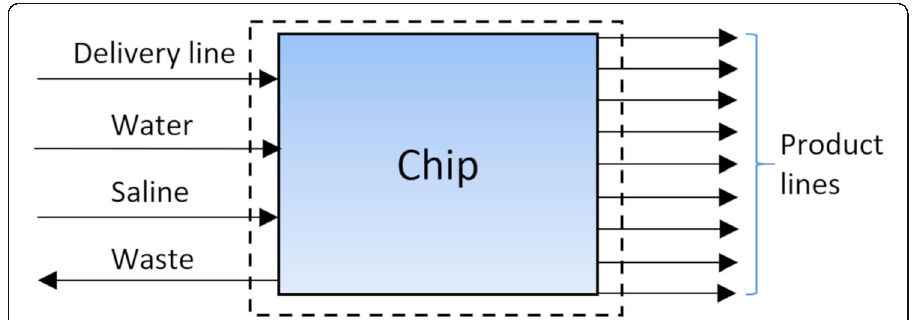
Fig. 10 Simplified system boundaries for the nine-run [ 13 N]NH 3 chip. The radioactivity enters the chip through the delivery line and is retained on one of nine SPE cartridges on separated fluid paths. The transporting target fluid leaves the system again and flows into the waste. Water is used to flush the SPE cartridge and also flows into the waste. Saline is used to elute and formulate the [ 13 N]NH 3 through one of nine product